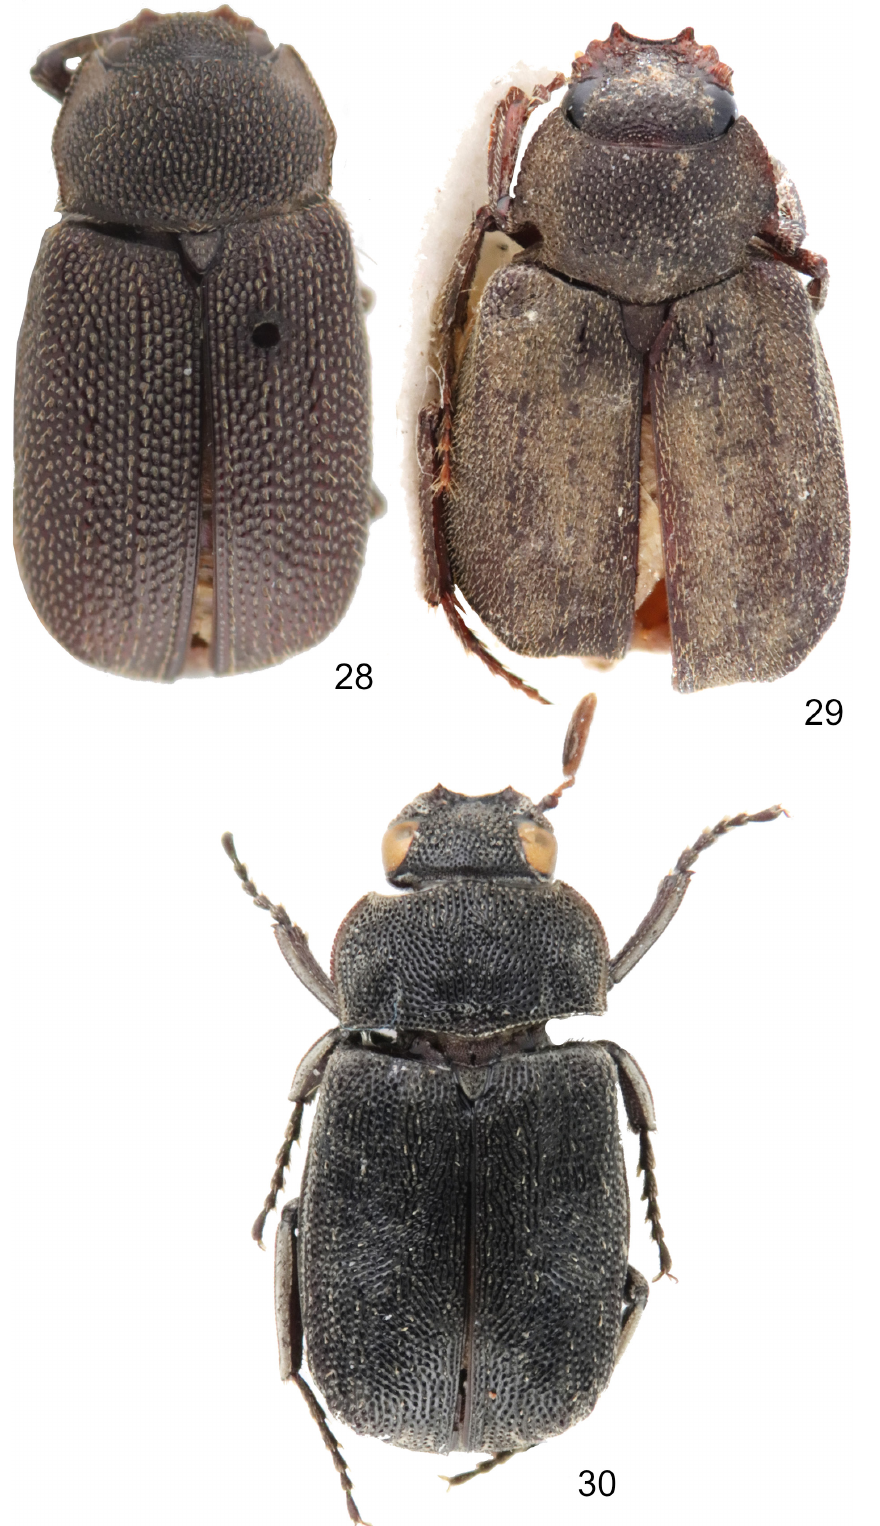
Figs 28–30. Papuan and Wallacean Maechidius Macleay, 1819, habitus, dorsal view. 28 . M. boessnecki sp. nov., holotype, ♂ (SNSD). 29 . M. brocki sp. nov., holotype, ♂ (BMNH). 30 . M. caperatus sp. nov., holotype, ♂ (NME). Not to